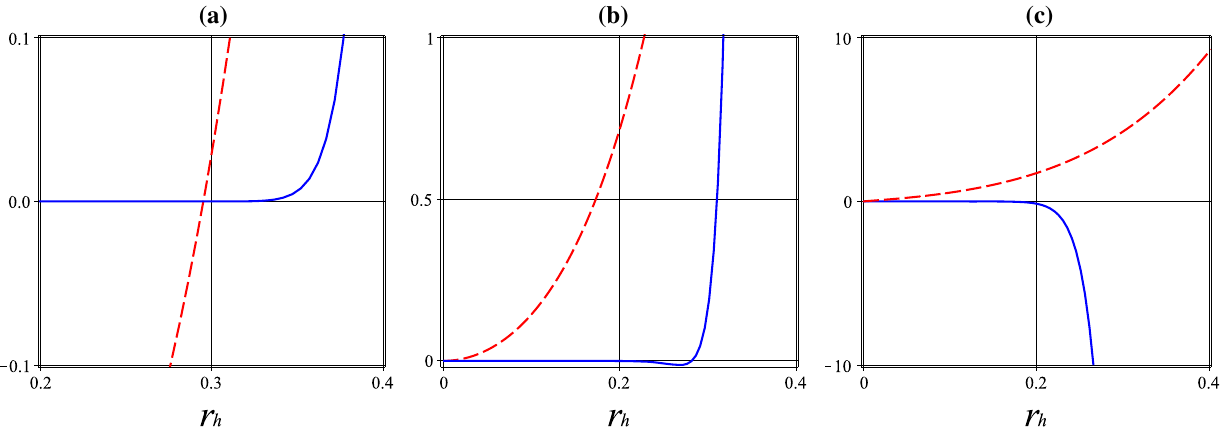
The points which satisfy condition (28) called critical